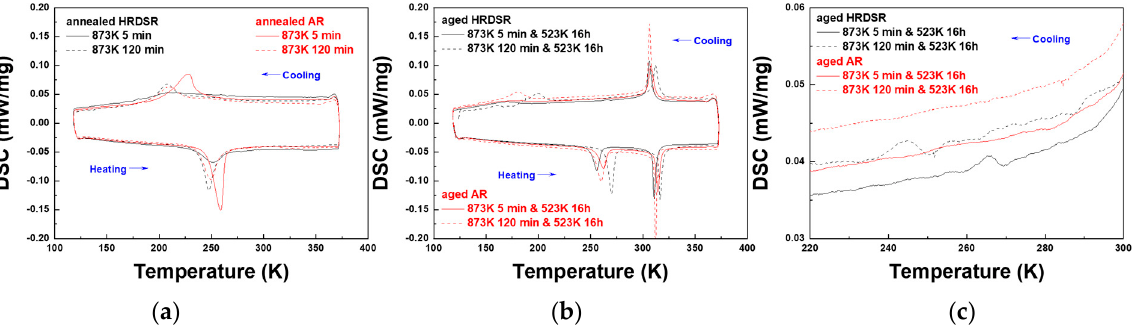
Figure 5. The DSC curves for ( a ) the annealed and ( b ) the aged AR and HRDSR samples. ( c ) The DSC curves for the aged AR and HRDSR samples magnified in the temperature range between 220 and 300 K upon cooling.